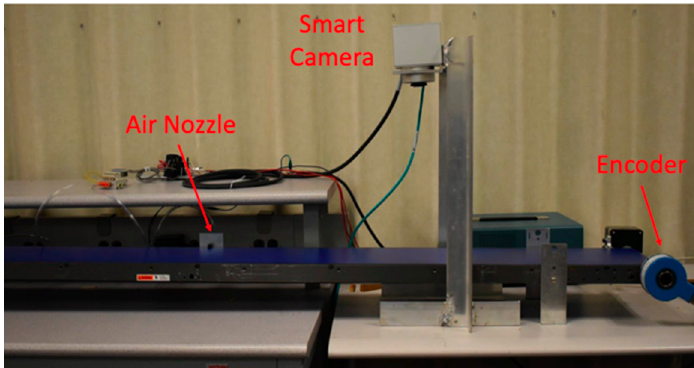
Figure 6. Software/hardware system diagram.